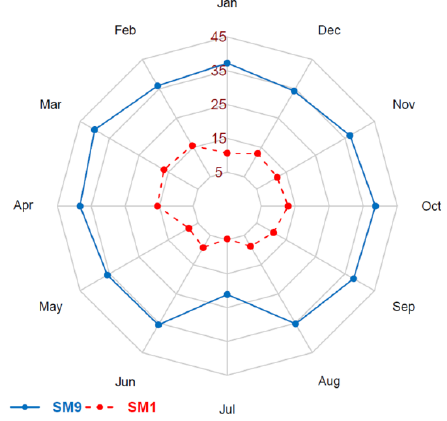
Figure 3. Radar chart of average soil moisture available data (in percent) over 8 catchments in each month for SMAP 9 km (SM9) and SMAP 1 km (SM1) during 2017–2019.